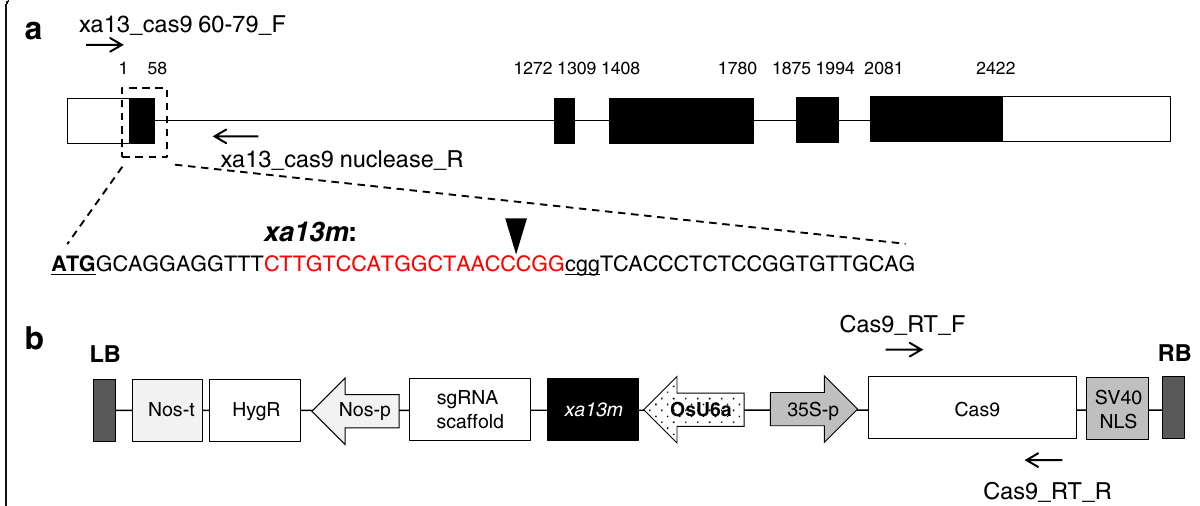
Fig. 2 Schematic representation of CRISPR/Cas9-mediated targeted mutagenesis in the rice Os8N3 gene. a Schematic diagram of Os8N3 gene and xa13m targeting sequence . Rice Os8N3 contains five exons, represented by black rectangles, and the untranslated region portion, represented by white rectangles. The enlarged area indicated by the black broken line shows the coding sequence and position of the first exon of Os8N3 . The 20-bp sgRNA targeting sequence ( xa13m ) and protospacer adjacent motif (PAM) sequence are shown in red and in underlined lower-case letters, respectively. The vertical arrowhead indicates an expected cleavage site. The underlined bold ATG indicates a translation initiation codon. b T-DNA region of the recombinant OsU6a:: xa13m-sgRNA /pHAtC vector carrying xa13m-sgRNA under the control of the OsU6a promoter. Expression of Cas9 is driven by the Cauliflower mosaic virus 35S (CaMV35S) promoter; expression of the xa13m-sgRNA is driven by the OsU6a promoter; expression of hygromycin (HPT) is driven by the nopalin synthase (NOS) promoter; NLS: nuclear localization signal of Simian virus 40 (SV40) large T antigen; nos-t: gene terminator; LB and RB: left and right border, respectively. Primers used in the PCR are indicated by black